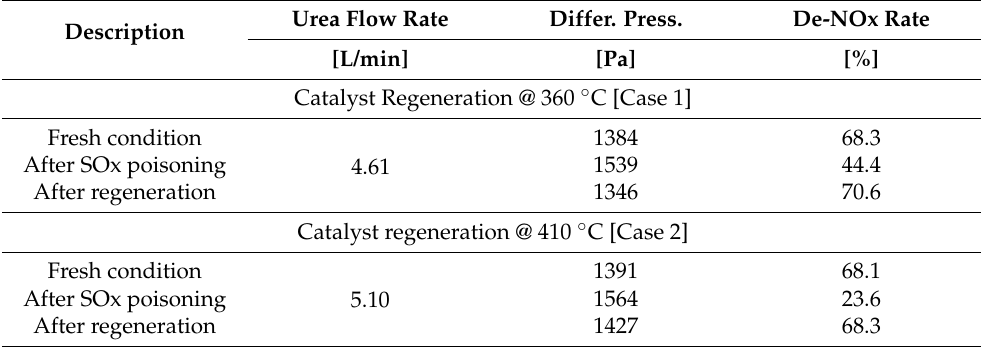
Table 7. De-NOx performance with plasma burner operation at different temperatures (exhaust condition refer to Table